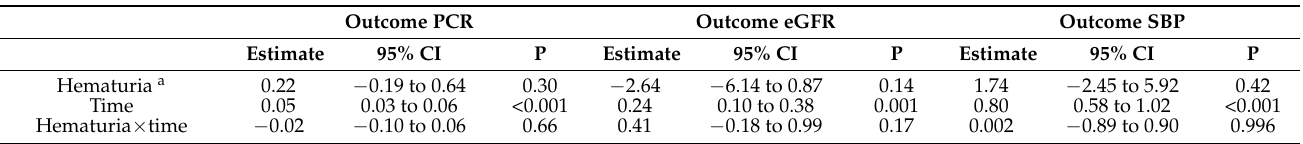
Table 3. Linear mixed model analysis for the associations between pre-donation hematuria and post-donation ln(PCR), eGFR, and SBP over time in a subgroup of high-risk donors.